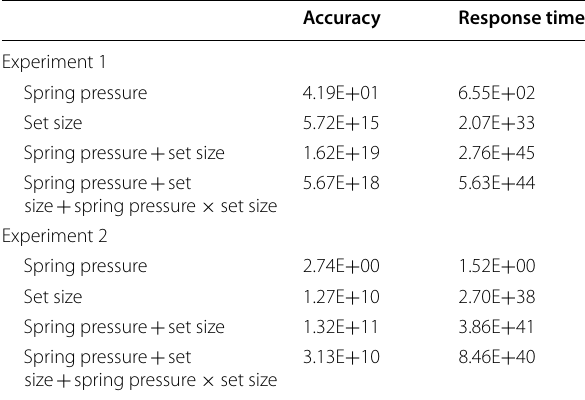
Table 1 Bayes factor ANOVA statistics for behavioral